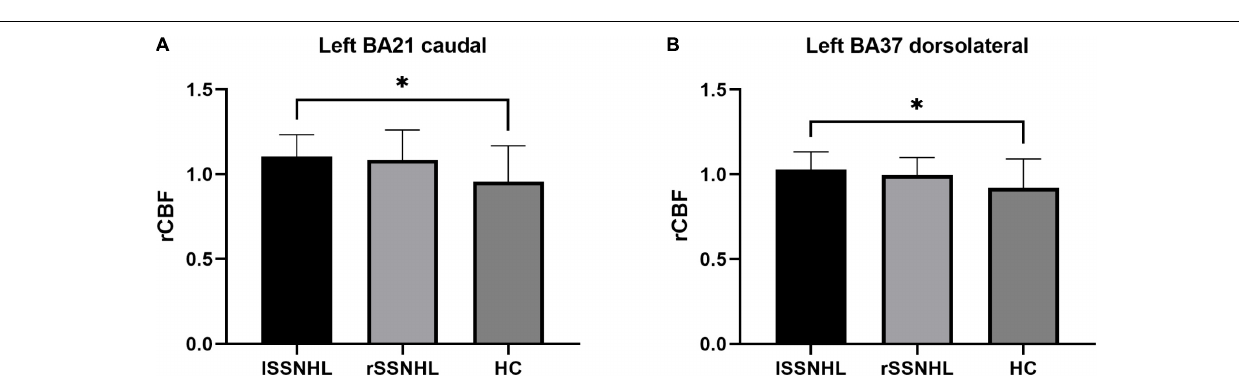
FIGURE 5 | Comparisons of rCBF values between healthy controls and patients with SSNHL. (A) Decreased CBF subregions in patients with unilateral SSNHL compared with healthy controls. (B) Increased CBF subregions in patients with unilateral SSNHL compared with healthy controls. Data was mean ± SD. I, ipsilateral; C, contralateral; MFG, middle frontal gyrus; PrG, Precentral Gyrus; SPL, superior parietal gyrus; ITG, inferior temporal gyrus; OrG, orbital gyrus; SD, standard deviation.